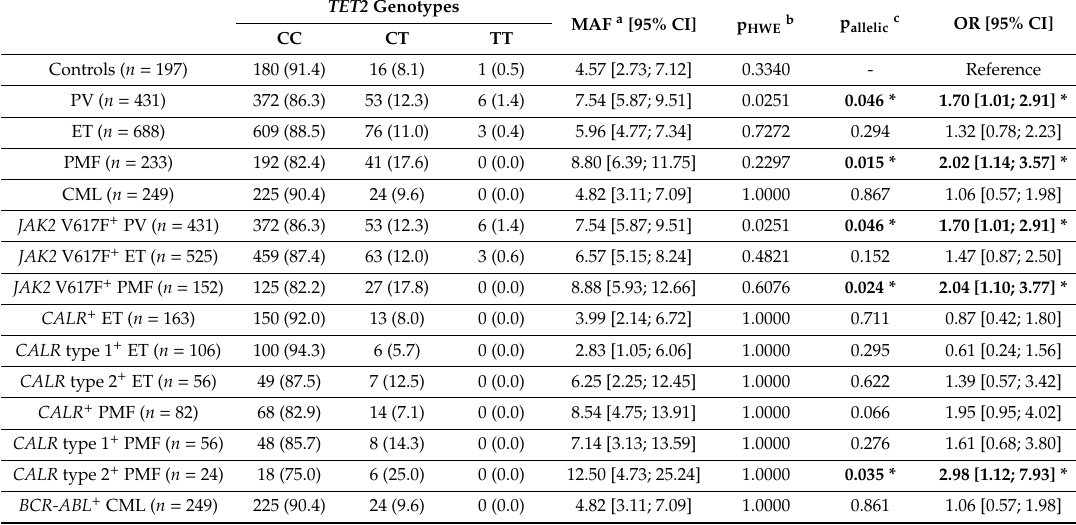
Table 2. TET2 rs154843 SNP (single nucleotide polymorphism) distribution in control group and MPN (myeloproliferative neoplasm)